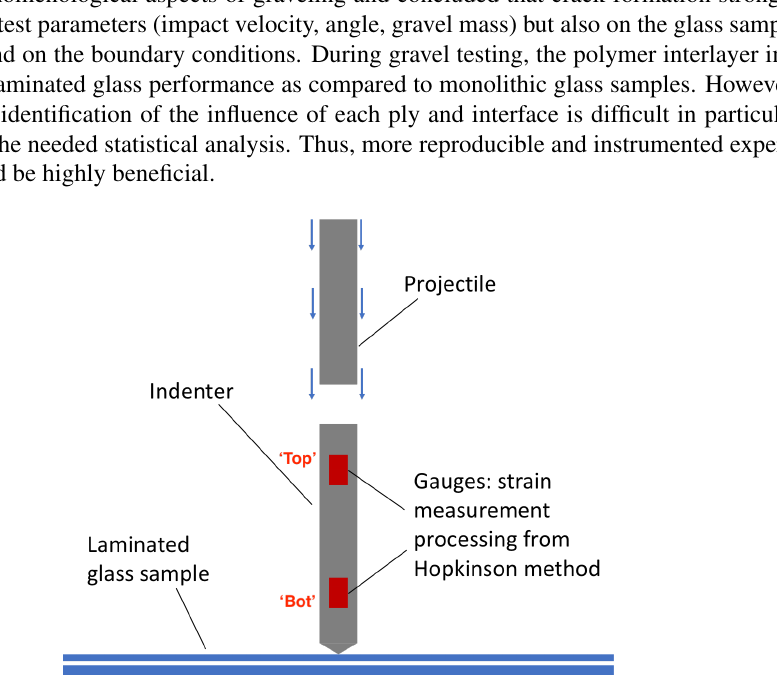
Fig. 1. Scheme of a newly designed “blowpipe” experiment. It includes an initially moving projectile and an initially motionless indent placed on the external glass surface. Two gauge locations are represented: the ‘top’ gauge, closer to the projectile and the bottom (‘bot’) gauge closer to the indent